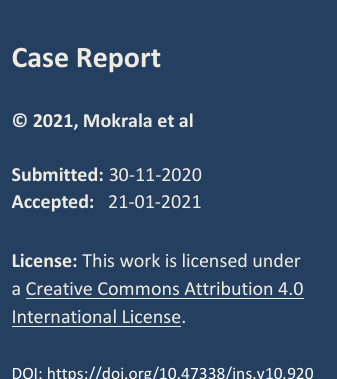
foramen ovale (PFO), small atrial septal defect (ASD)